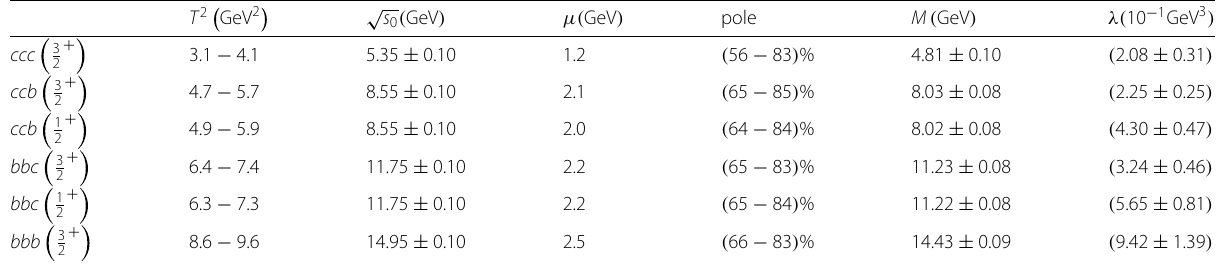
Table 1 The Borel windows, continuum threshold parameters, energy scales of the QCD spectral densities, pole contributions, masses, and pole residues for the triply heavy baryon states √ T 2 GeV 2 s 0 ( GeV ) pole